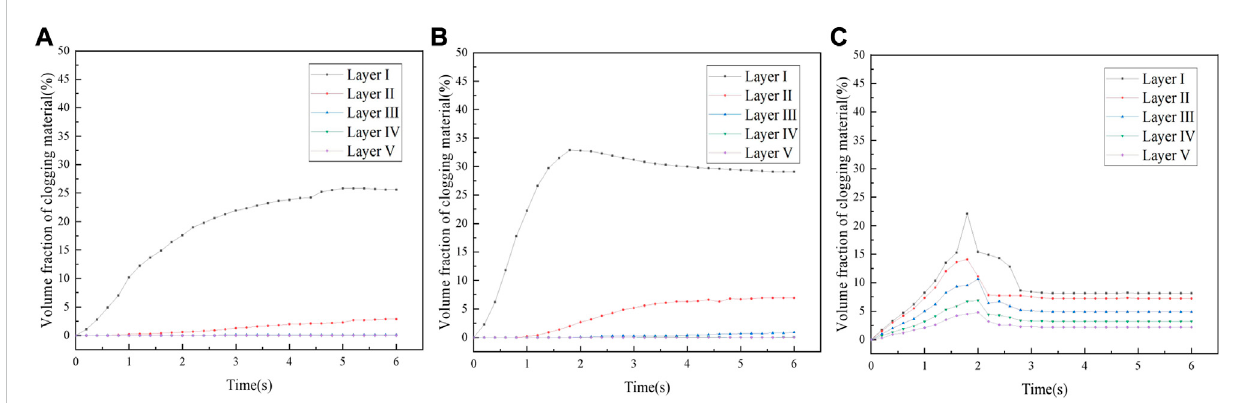
FIGURE 15 Distribution of clogging substances at different pervious pavement depths. (A) P A1 ; (B) P A2 ; (C) P A3